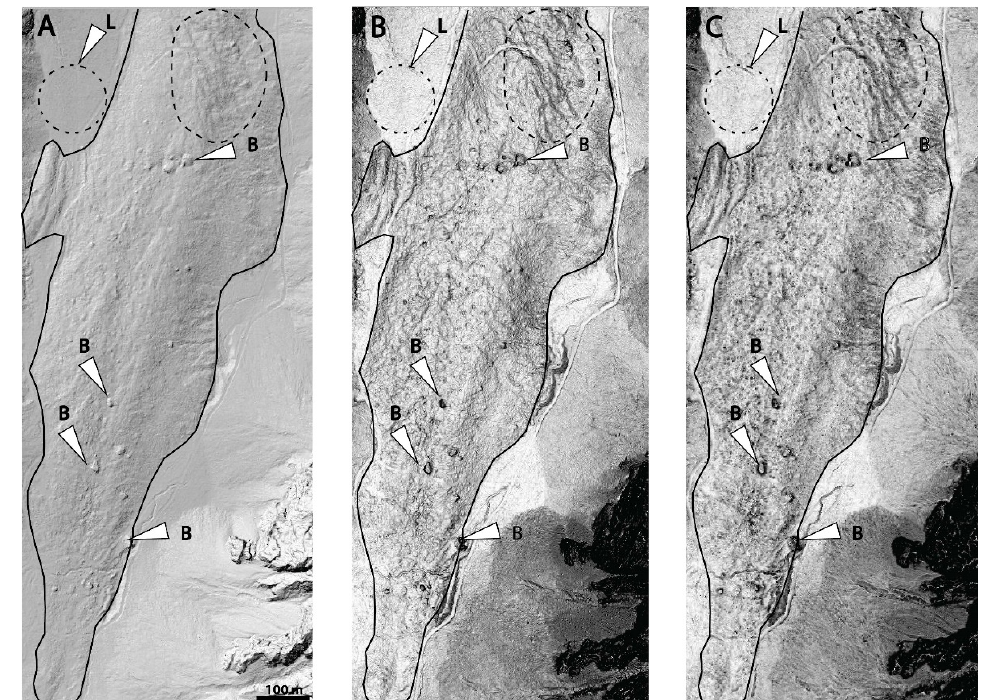
Figure 6. Largest glacial moraine covering the valley floor (delineated with full line) and location of outcropping lacustrine deposits (L, marked by the dashed circle and white arrow). White arrows point to large boulders (B), and the area on the moraine marked with a dashed line represents its typical undulated terrain. The area is represented on ( A ) analytical hillshading (A315, H35), ( B ) 8-bit sky view factor and ( C ) 8-bit slope visualisations respectively. For location see rectangle 6 in Figure 1.